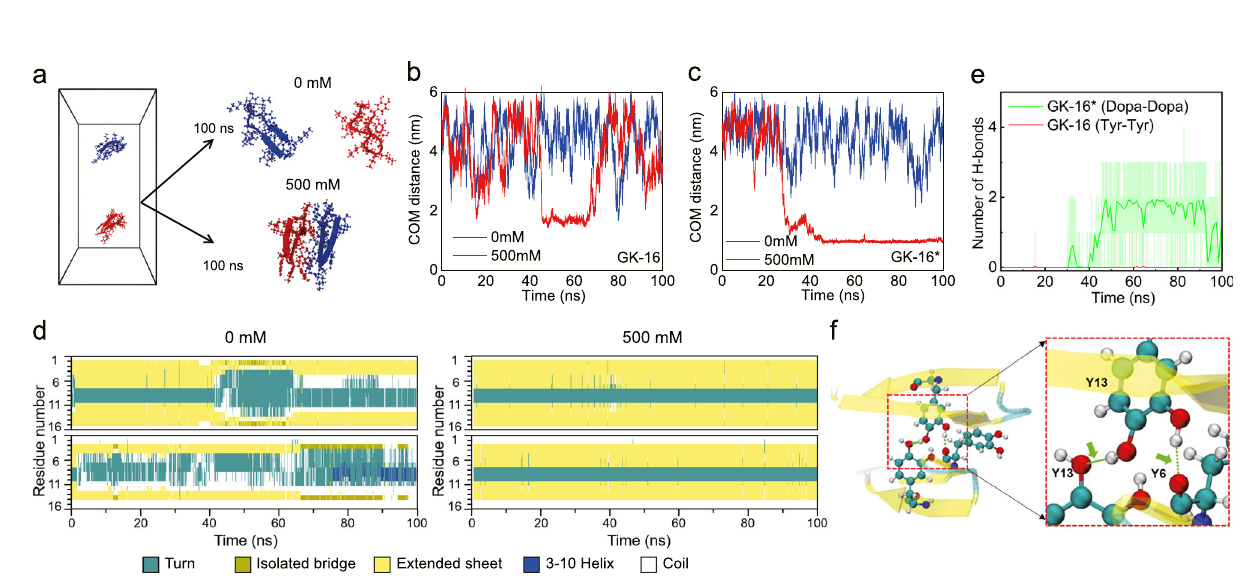
Fig. 3 | MD simulations of the pair interactions of GK-16 and GK-16* peptides. a Simulation models; left: simulation box with initially separated peptides; right: the fi nal snapshots of GK-16* under 0 mM or 500mM ionic strength at 100ns. Water molecules and ions are not shown for clarity. The representative temporal evolutions of COM distances between the pairs of peptides with 0mM or 500mM ionic strength, for GK-16 ( b ) and GK-16* ( c ). d Residue maps of the secondary structures asafunction oftimefor GK-16* under0mM and 500mM ionic strength